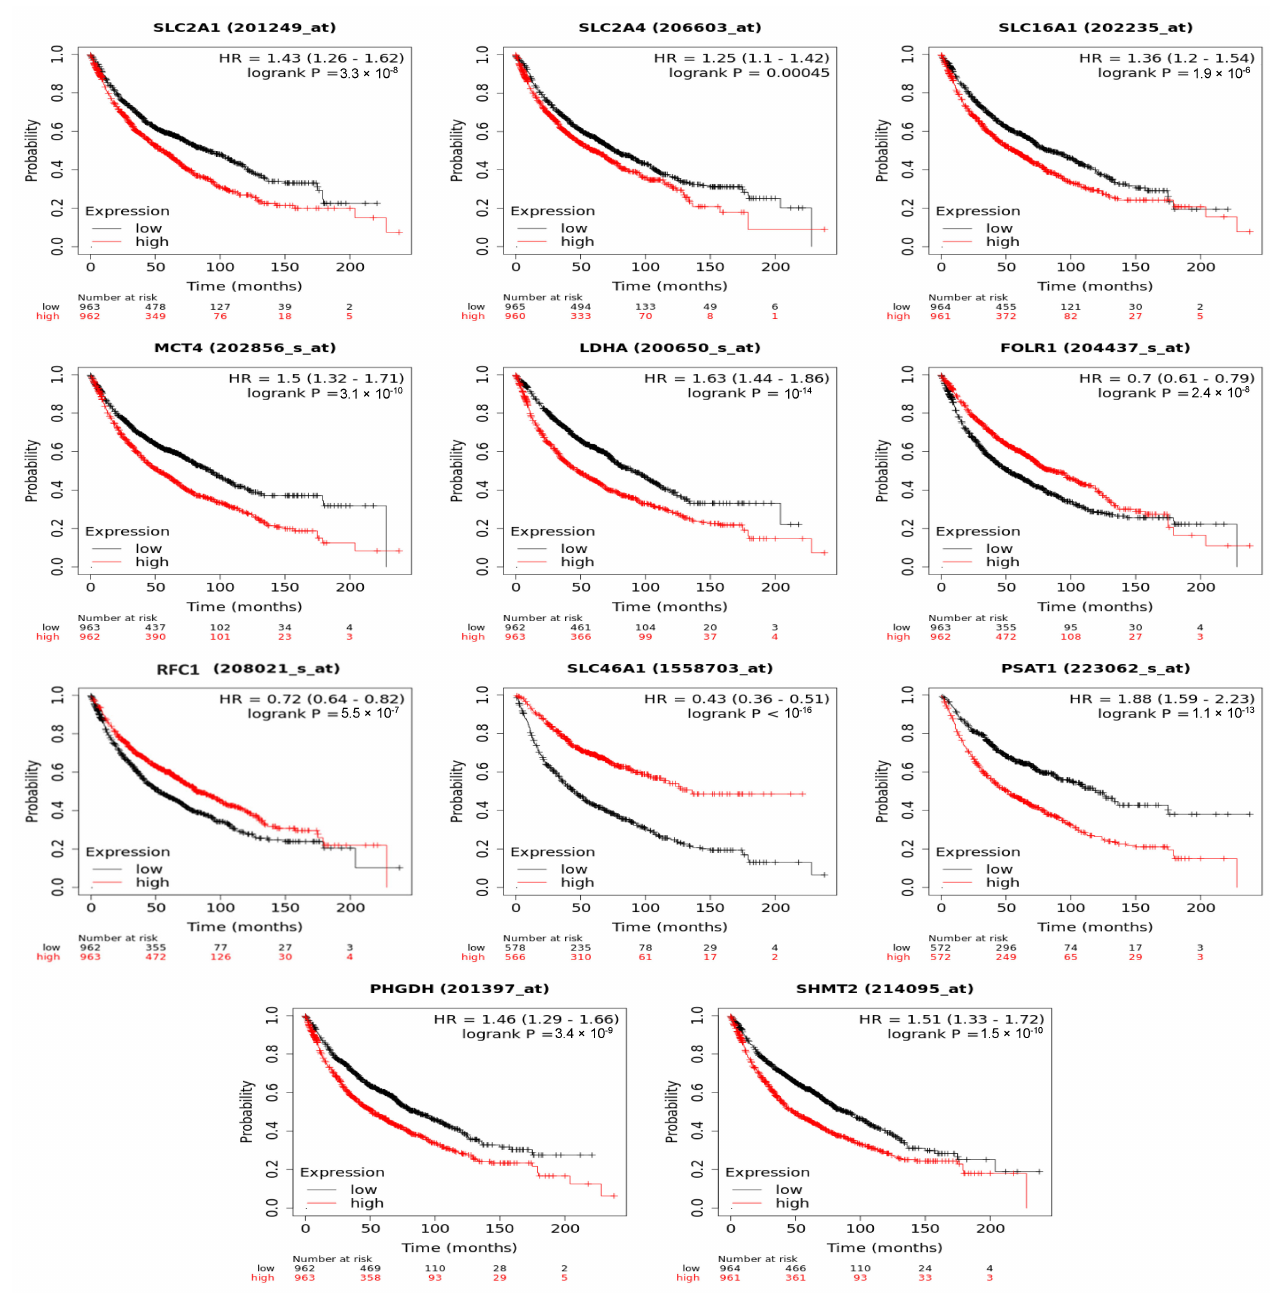
Figure 6. Folate-responsive aggressive tumours’ signatures predicted overall survival of patients with lung cancers. Kaplan–Meier survival curves for ADSL and ATIC genetic expression (high and low levels) was